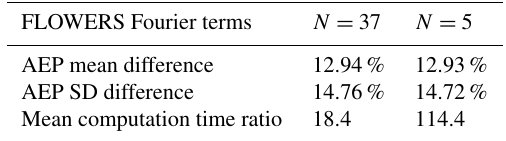
Table 1. Influence of number of Fourier modes in the FLOWERS solution for the 40 randomized AEP test